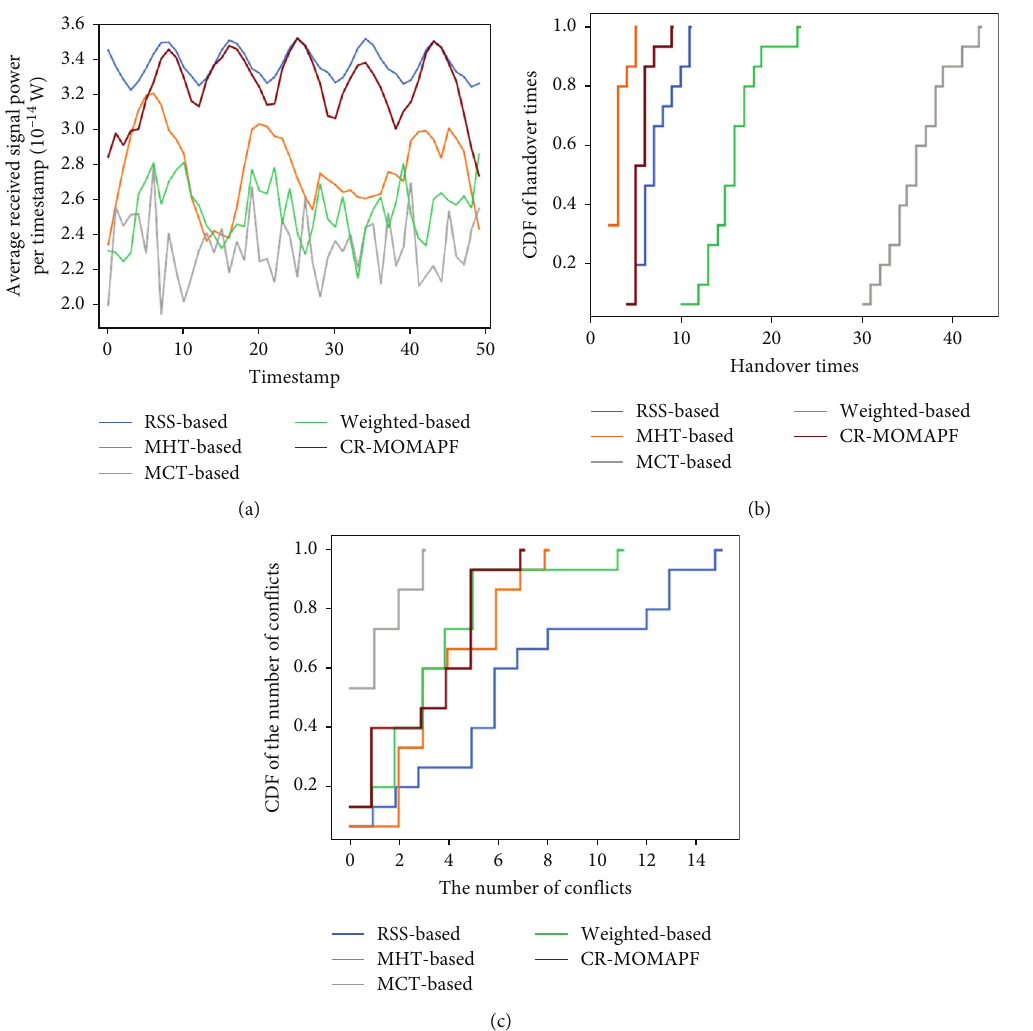
Figure 8: Performance of users with di ff erent handover strategies: (a) received signal strength; (b) handover times; (c) con fl ict times.